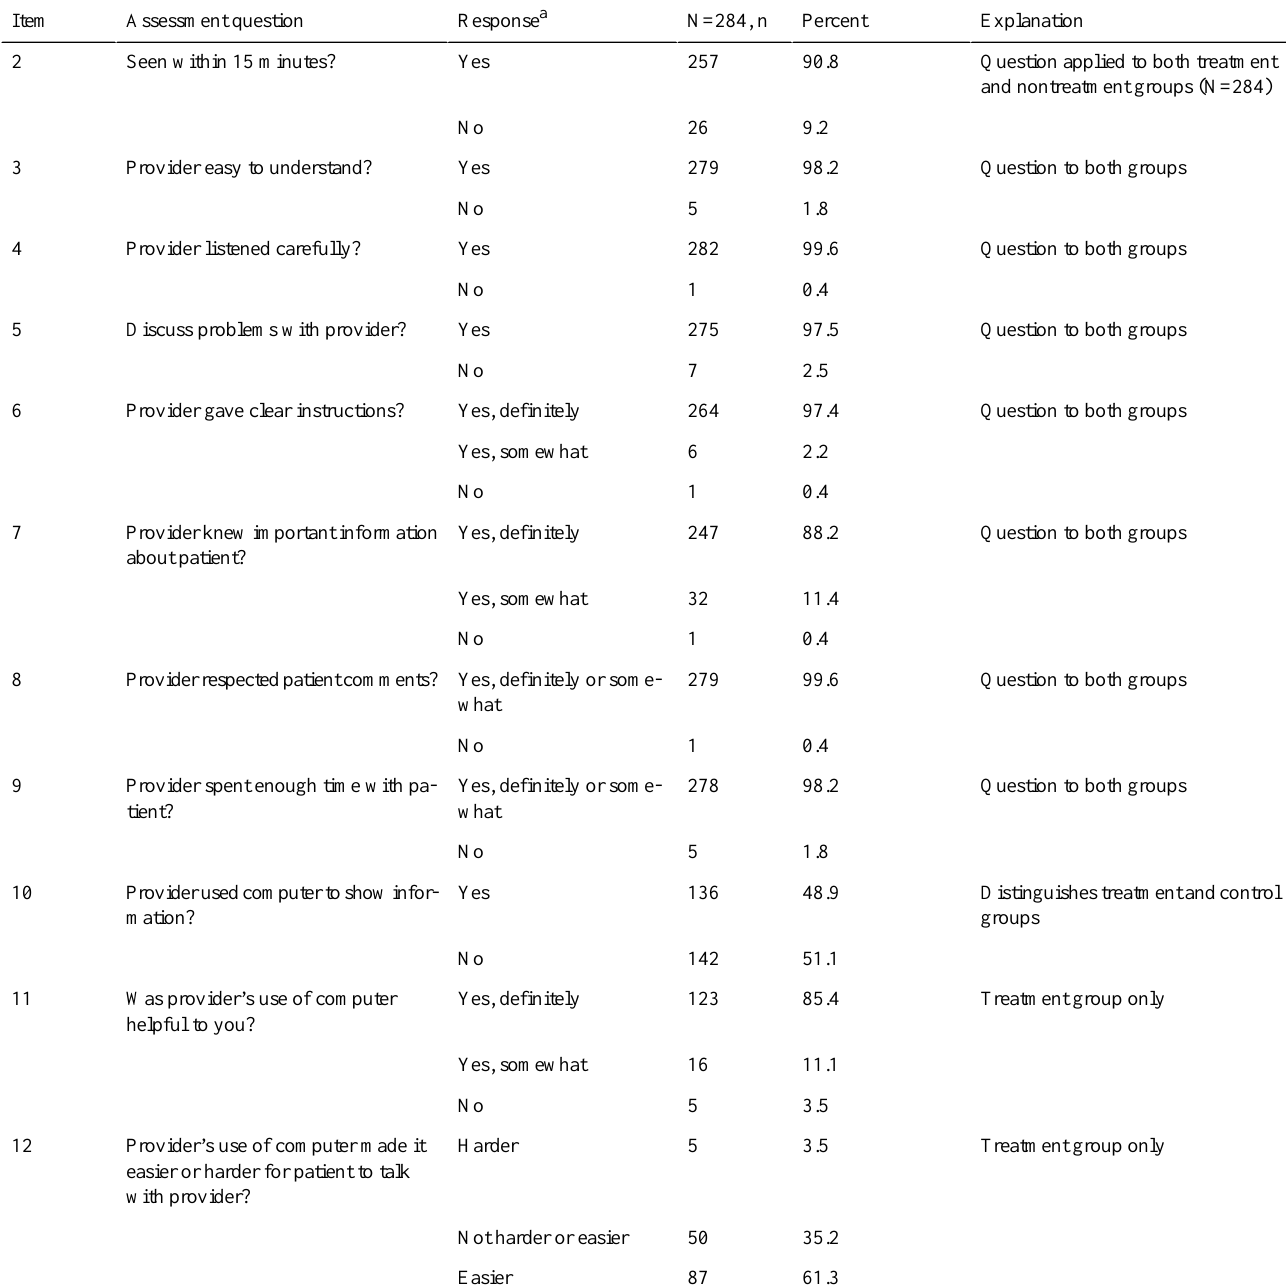
Table 1. Primary survey results, communication effectiveness, both